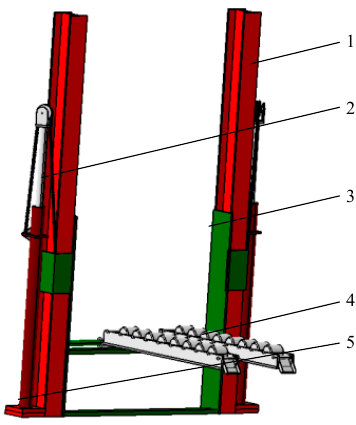
Figure 7. Structural diagram of the fruit-box-lifting device. 1 represents the support frame, 2 represents the chains, 3 represents the sliding frame, 4 represents the fruit box transport device, and 5 represents the lifting hydraulic cylinder. Agriculture 2023 , 13 , x FOR PEER REVIEW